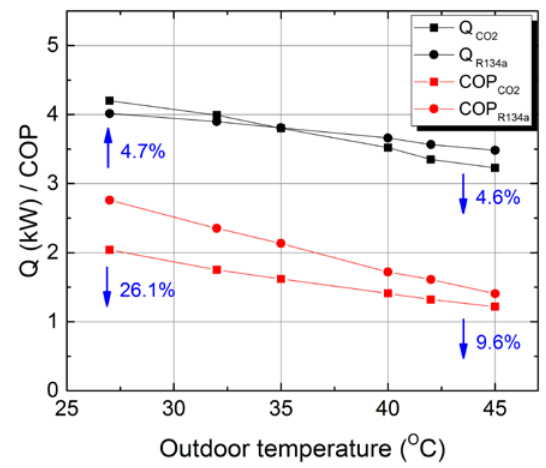
Figure 4. Cooling capacity and COP for CO 2 and R134a MAC systems at varied outdoor temperature.